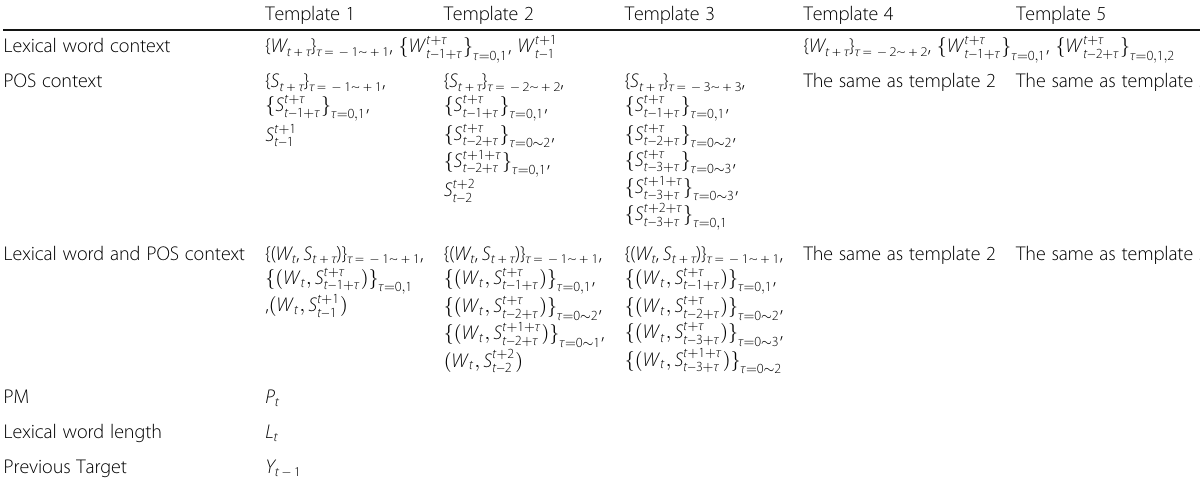
Table 13 Feature templates for bQC and